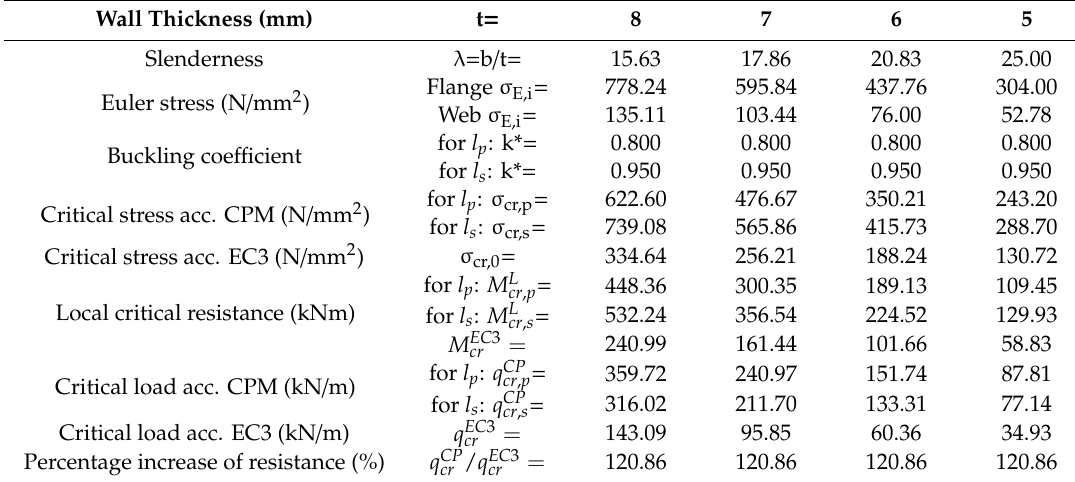
Table 1. Summary of critical results according to critical plate method (CPM) and European Eurocode 3 (EC3) for the I-300 × t × 250 × t section and four wall thickness